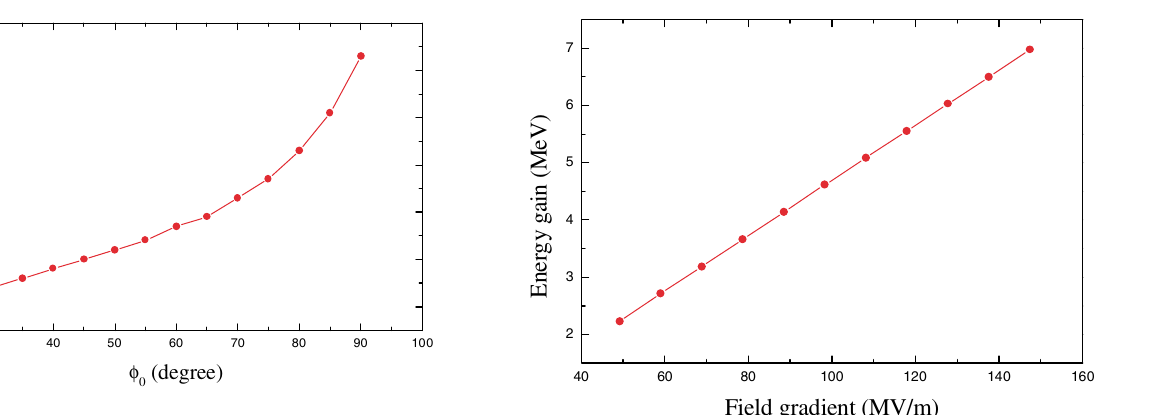
FIG. 6. (Color) Bunch length variation with rf phase at the cathode.